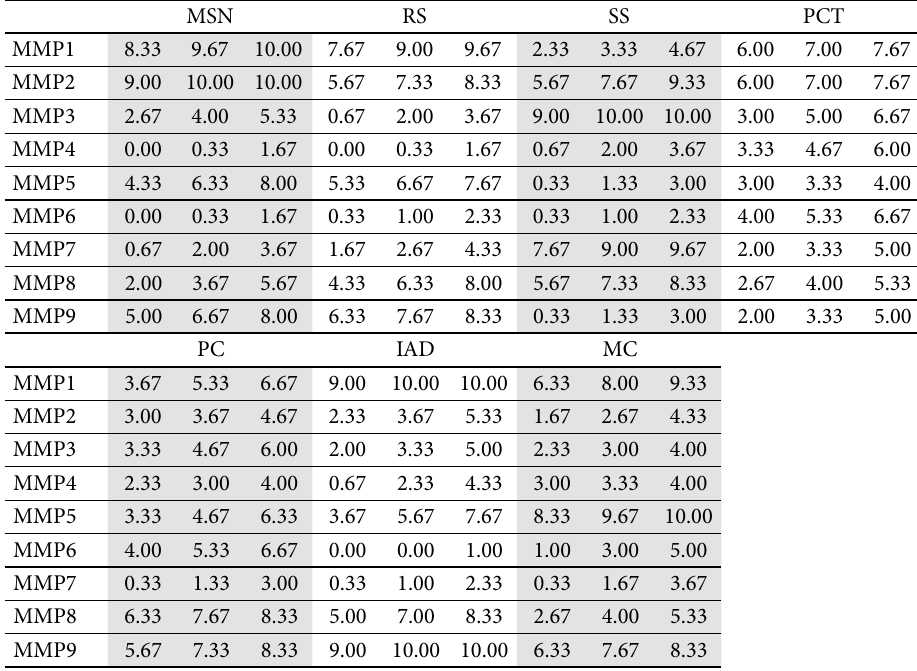
Table 9. The fuzzy decision matrix and fuzzy weights of alternatives MSN RS